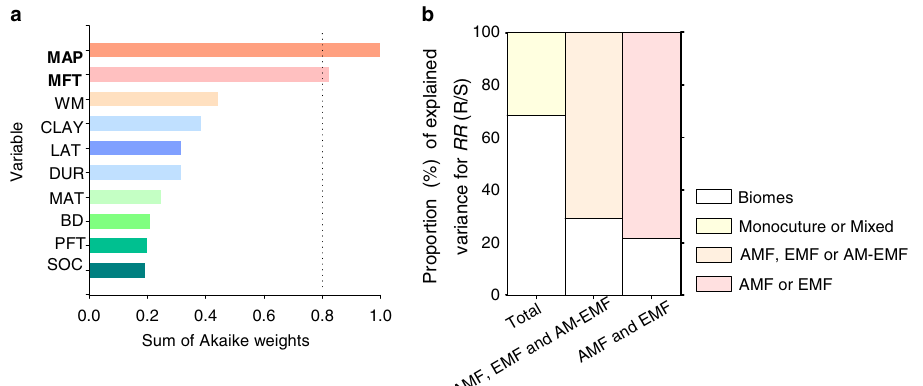
temperature, LAT latitude, CLAY the proportion of clay in soils, BD bulk density, SOC soilorganiccarbon, WM warming magnitude, DUR warming duration ( a ).The CLAY, BD, and SOC were from the topsoil at 0 – 30cm soil depth, the detailed information of these predictors is provided in Supplementary Table 3. Biomes include forest, grassland, cropland, tundra and wetland; Monocultures and mixed refer to plant communities with single plant species and multiple plant species, respectively. AMF, EMF, and AM-EMF indicated the biomes with dominant